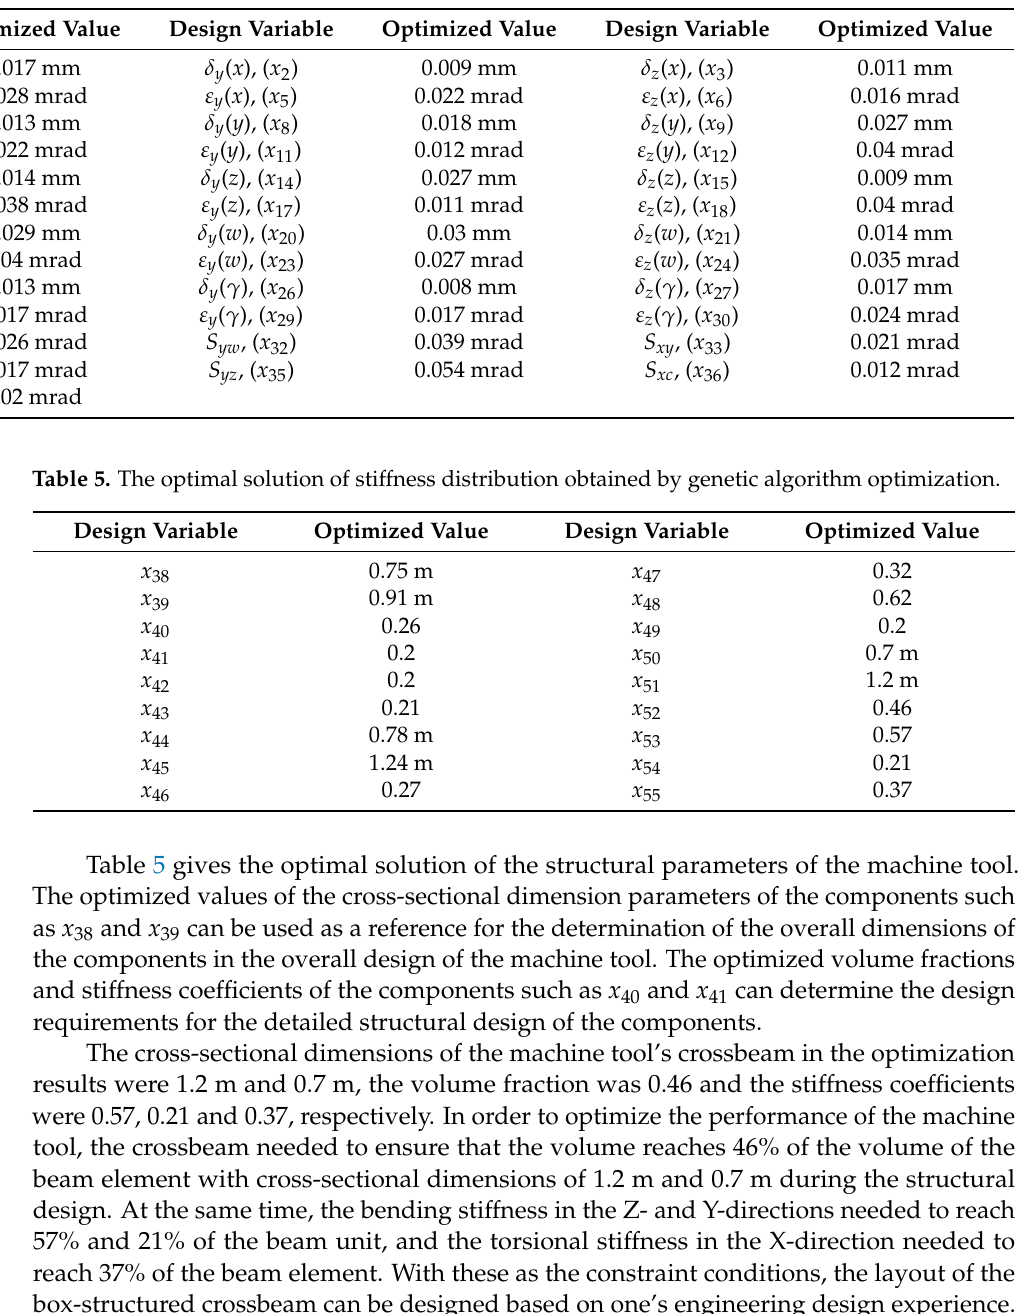
Table 4. The optimal solution of precision distribution obtained by genetic algorithm optimization.